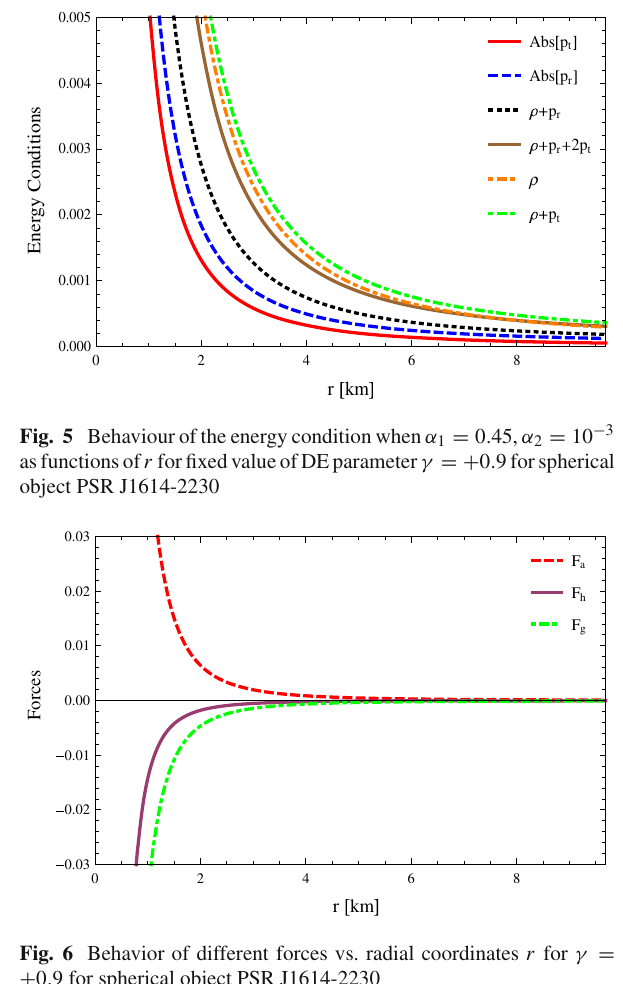
Fig. 6 Behavior of different forces vs. radial coordinates r for γ = + 0 . 9 for spherical object PSR J1614-2230